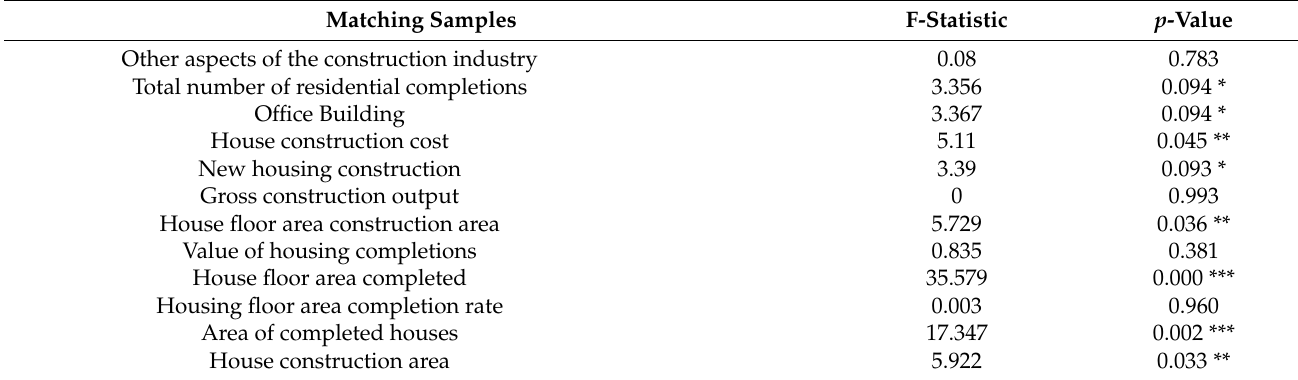
Table 4. Ridge regression results (***, ** represent 1%, 5% level of significance respectively).